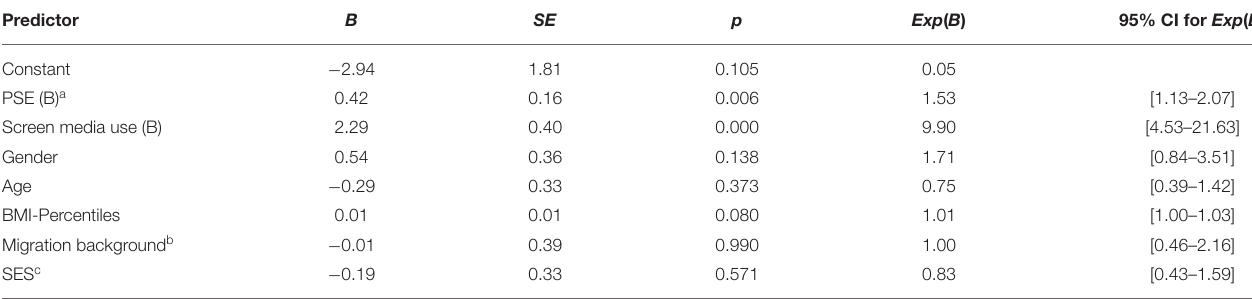
TABLE 3 | Parental self-efficacy at baseline as predictor of children’s screen media use at follow-up. Predictor B SE p Constant